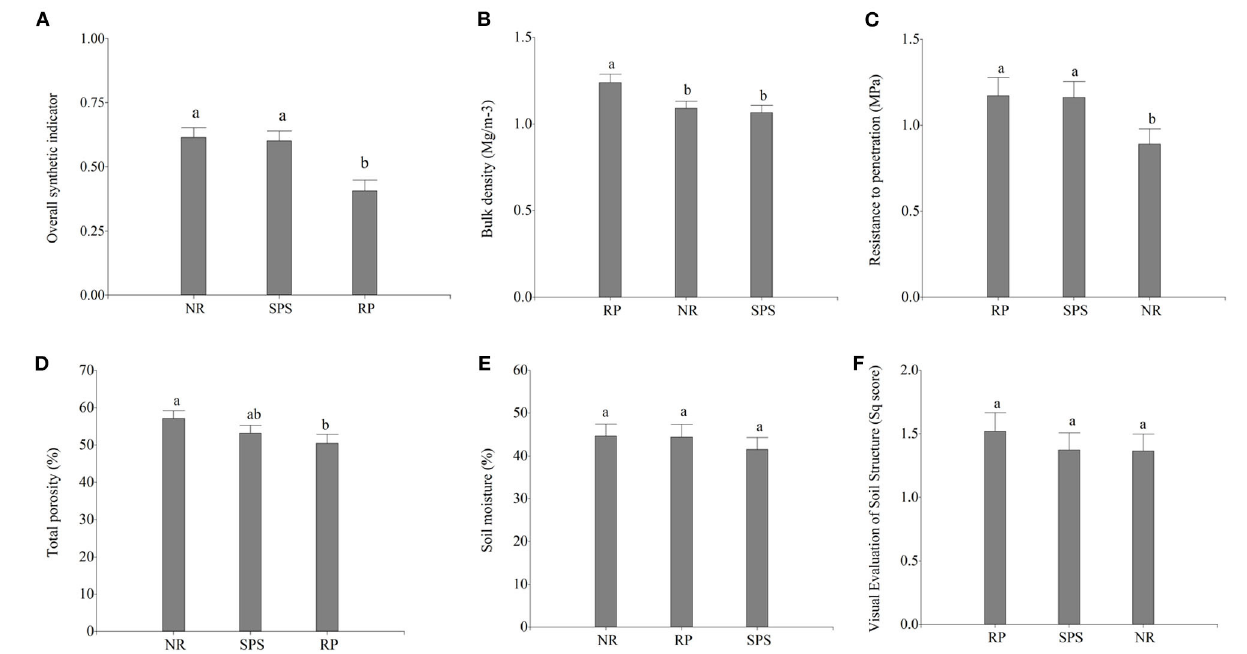
FIGURE 3 | Physical soil characteristics: (A) overall synthetic indicator of physical quality, (B) bulk density, (C) soil resistance to penetration, (D) total porosity, (E) soil moisture content, and (F) visual evaluation of soil structure in Natural Regeneration (RN), silvopastoral systems (SPS), and rubber plantations (RP) in Colombian Amazon region. The bars represent standard deviation, and the different letters indicate statistically significant differences according to the Fisher Test ( P <